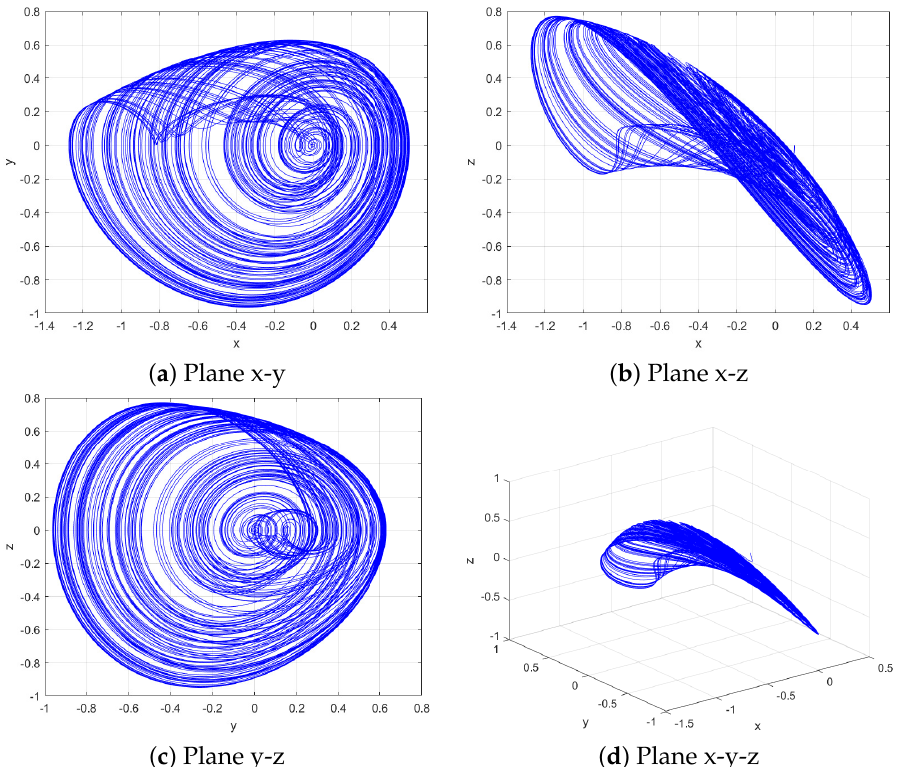
Figure 4. Phase-space portraits of the autonomous chaotic oscillator given in